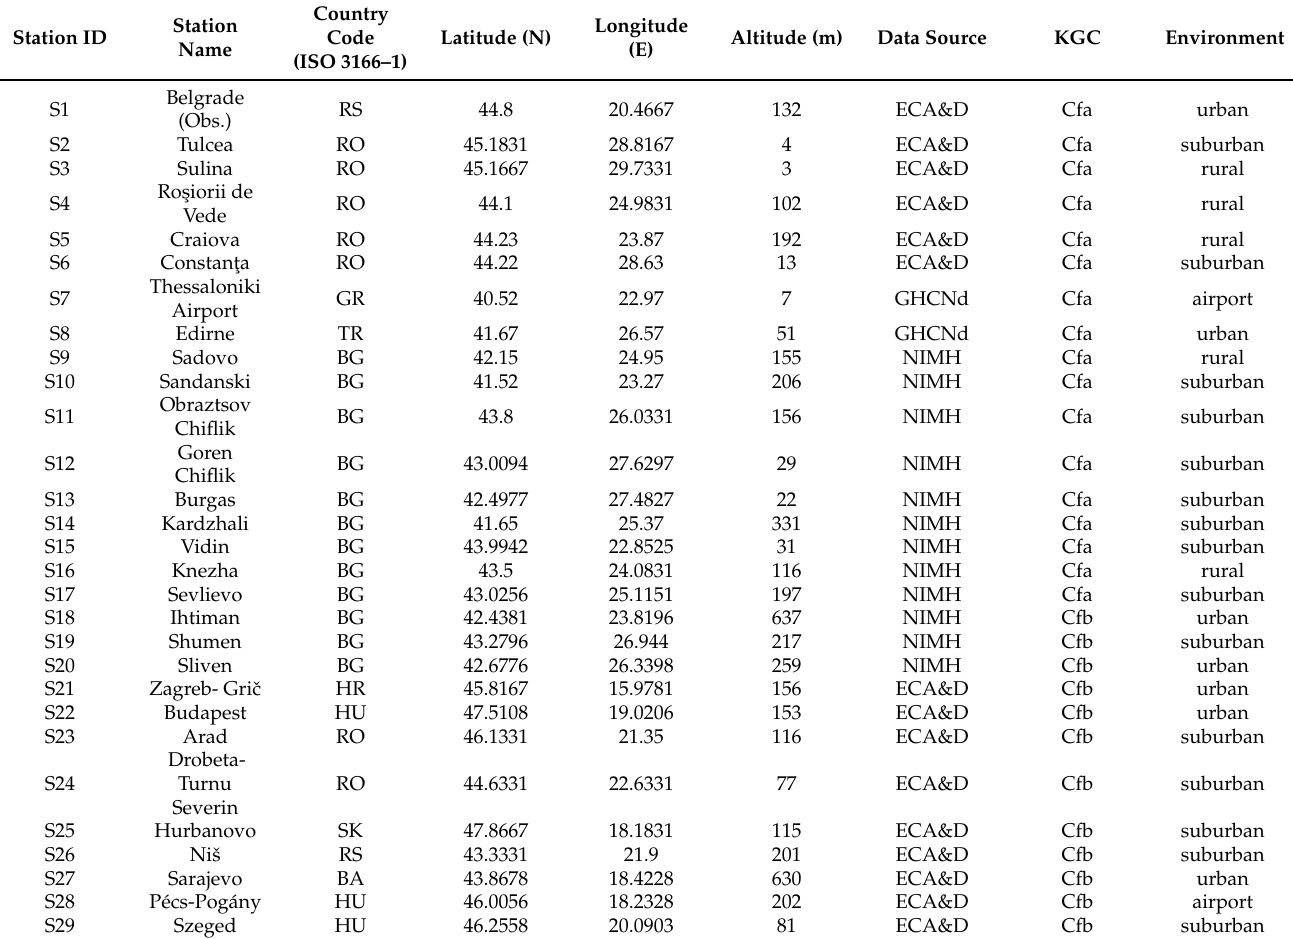
Table A1. Key information for the 12 selected stations from the NIMH network, 41 selected stations from the ECA&D database, 16 selected stations from the GHCNd dataset, and one station from the GSOD dataset; KGC denotes the Köppen–Geiger climate